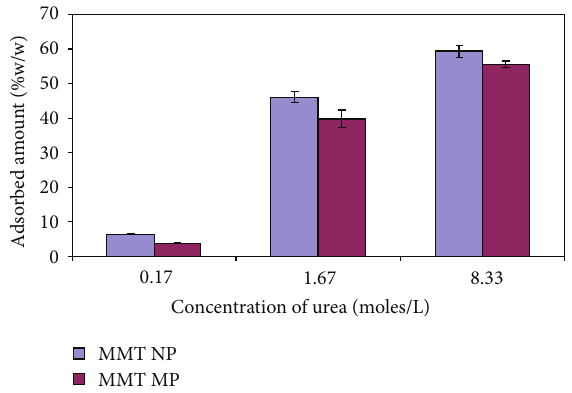
Figure 2: Efficiency of MMT NP and MMT MP in adsorption of urea.